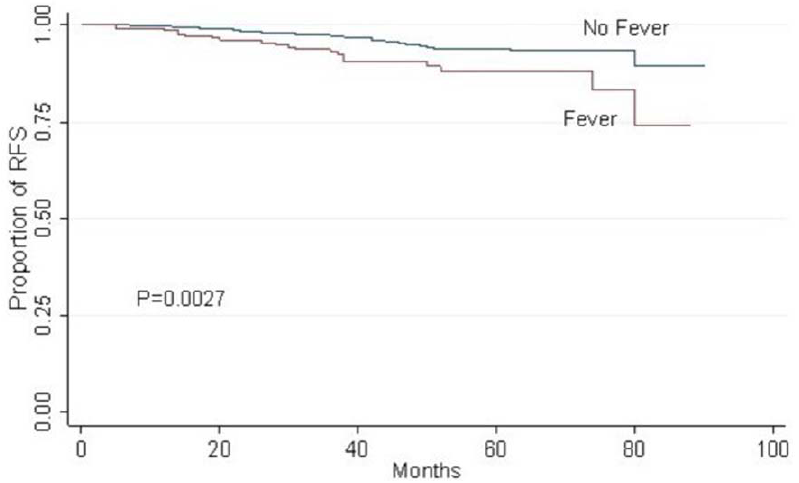
Figure 1. Kaplan–Meier curves for RFS in 883 ALN negative breast cancer patients by postoperative fever. doi:10.1371/journal.pone.0015903.g001 PLoS ONE |